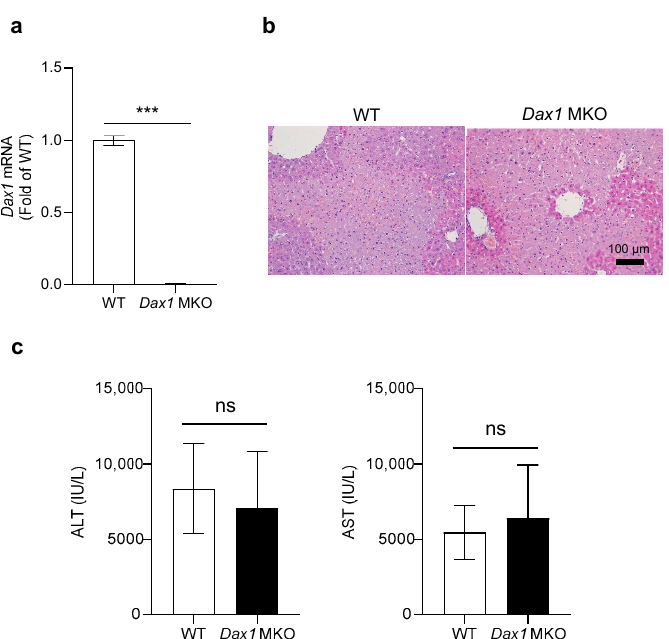
Figure 1. Myeloid cell-specific DAX1 deletion shows a similar effect to ConA-induced liver injury in mice. ( a ) Bone marrow-derived neutrophils from WT and Dax1 MKO mice were isolated, and mRNA extracts from cells were conducted using quantitative real-time PCR (RT-qPCR) to measure the expression levels of Dax1 (RT-qPCR was performed in seven technical replicates). ( b , c ) C57BL/6J (WT) and myeloid cell-specific Dax1 knockout (MKO) mice were treated with single administration of concanavalin A (ConA) (15 mg/kg, i.v.) for 9 h (WT; n = 7, MKO; n = 6). ( b ) Hematoxylin and eosin (H&E) staining was performed in the liver tissues, and representative images are shown. ( c ) Plasma levels of alanine aminotransferase (ALT) and aspartate aminotransferase (AST). Data are expressed as the mean ± SEM. Two ‐ tailed Student’s t ‐ test was used to compare the MKO and WT groups; *** p < 0.001 and ns = not significant.